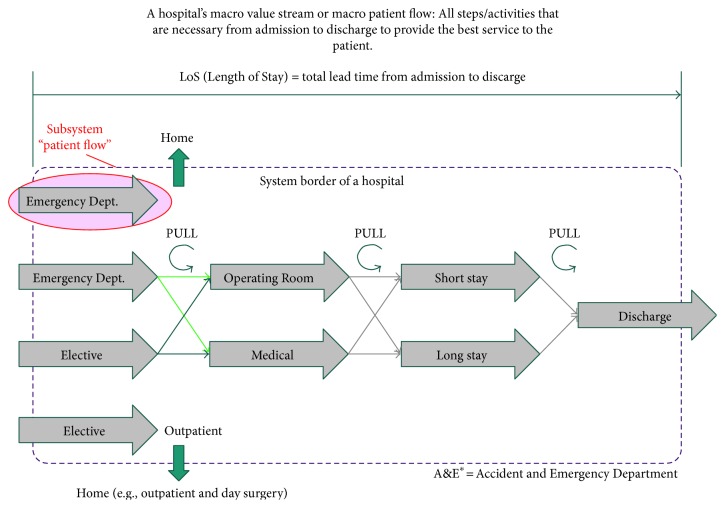
Patient flows in the hospital system [27].